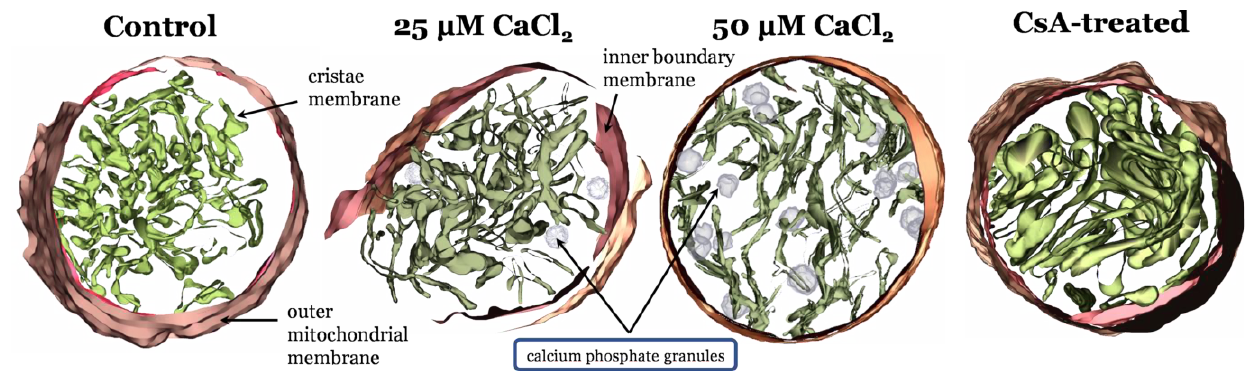
Figure 2. Mitochondrial ultrastructural changes associated with calcium overload. From left to right, IMOD [16] 3D mitochondrial reconstructions from cryo – electron tomography data where mitochondria were exposed to zero Ca 2+ , a bolus of 25 µM CaCl 2 , a bolus of 50 µM CaCl 2 [2], and 1µM CsA. Calcium causes a decrease in cristae volume in a titratable manner. CsA leads to an expanded cristae volume and altered outer membrane morphology.